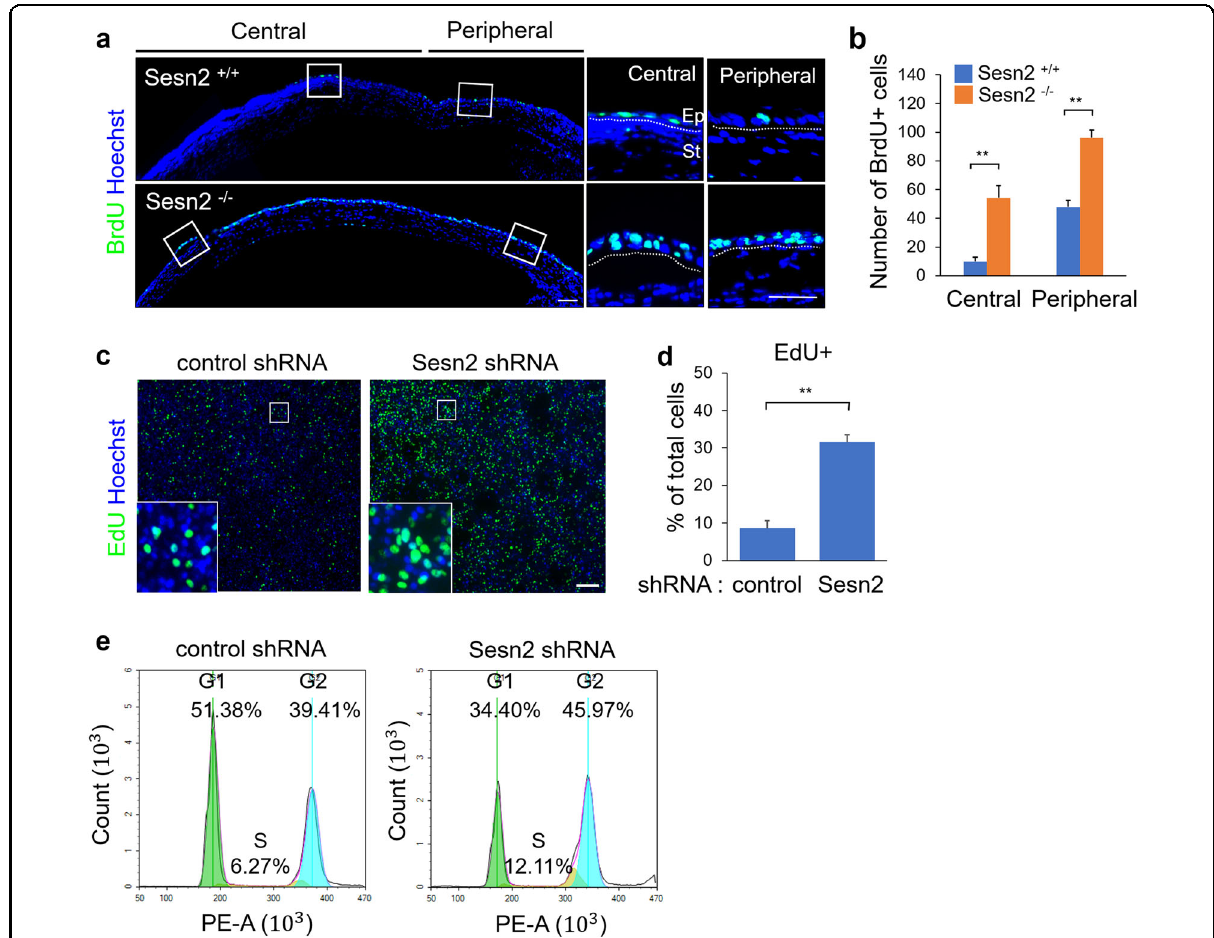
Fig. 2 Sesn2 de fi ciency promotes corneal epithelial cell proliferation. a BrdU was injected into Sesn2 − / − and Sesn2 + / + mice after injury, and the mice were sacri fi ced 48 h. Corneal sections were stained using an anti-BrdU antibody (green). Hoechst dye was used as a counterstain (blue). BrdU- positive cells were observed in the central and peripheral regions of corneal epithelial layers and were primarily detected in Sesn2 − / − mice. Dotted lines indicate the basement membrane. b Quantitative analysis of BrdU-positive cells in the corneal epithelium of Sesn2 − / − and Sesn2 + / + mice after injury. c EdU incorporation assay of hCET cells expressing Sesn2 shRNA or control shRNA. Cells were incubated with 10 µM EdU for 4 h. d Percentage of EdU-positive cells. The number of EdU-positive Sesn2-de fi cient hCET cells was signi fi cantly increased. e Distribution of cells in different cell cycle phases. The proportion of Sesn2-de fi cient hCET cells in the S and G2 phases of the cell cycle was higher than that of control cells. Error bars represent the means ± SD of three independent experiments. Two-tailed Student ’ s t -test (** p < 0.01). Scale bars, 50 µm in ( a ); 100 µm in ( c